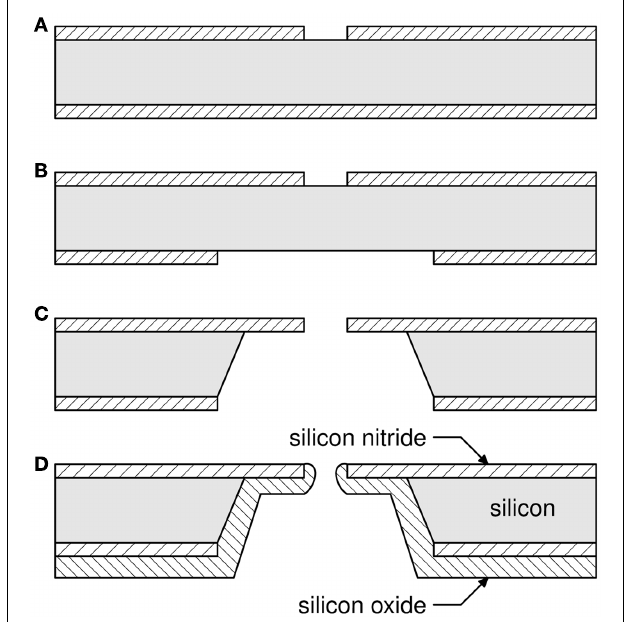
FIGURE 2 | One-aperture silicon patch-clamp chip fabrication process. (A) A circular 4 μ m aperture was etched in the top silicon nitride film; (B) A square 600 μ m × 600 μ m was etched in the bottom silicon nitride film, aligned with the aperture; (C) KOH etches a pyramidal well and leaves silicon nitride self-standing; (D) A 5.4- μ m thick silicon dioxide film passivates the well, rounds the edges of the aperture. A much thinner layer (not shown) is also sputtered on the font side to facilitate cell attachment. From (Py et al., 2010)